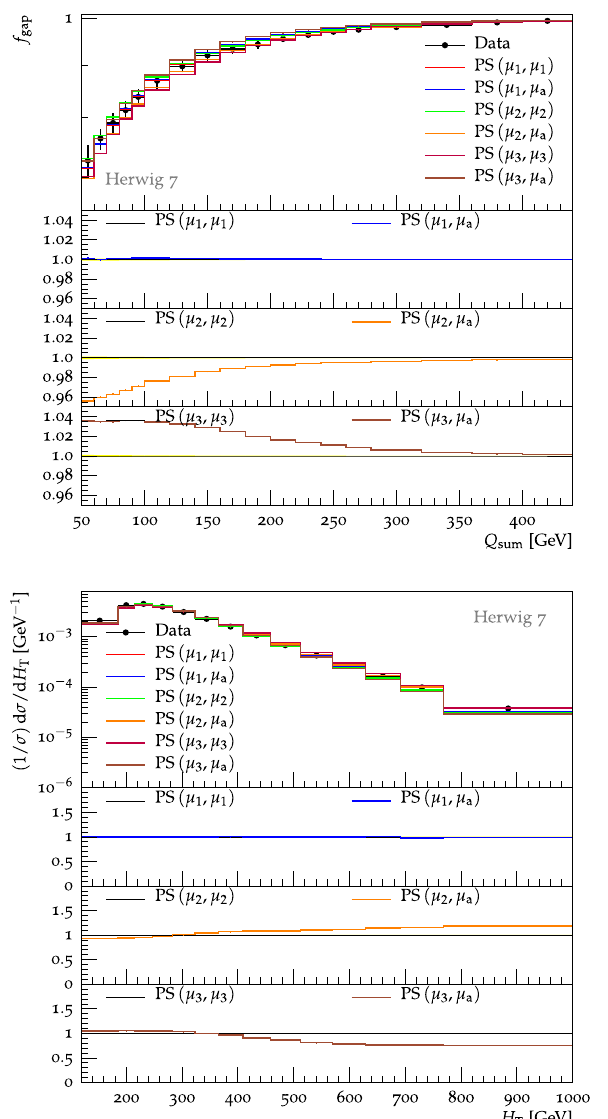
Fig. 15 Top: the gap fraction measured by ATLAS in dileptonic 7TeV pp → t ¯ t events [66], in veto region | y | < 2 . 1, and predicted using the angular-ordered (PS) and dipole (DS) parton showers, respectively.